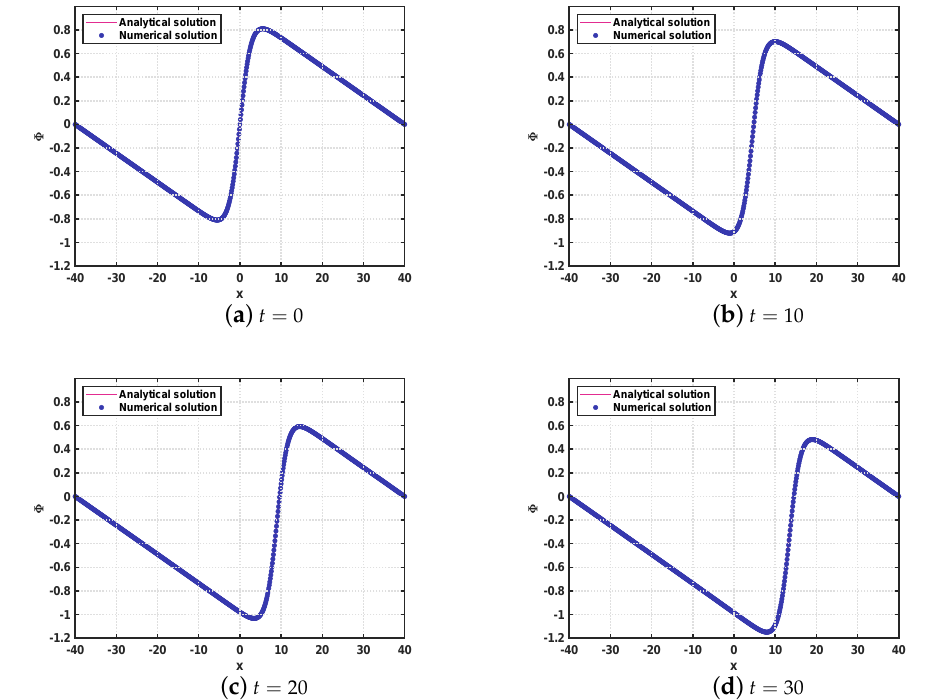
Figure 3. Comparison between numerical solution Φ f ( • ) and analytical solution Φ ( − ) with = 1 τ = τ C and h = 1 at different points in time for Case 1 of Example 2. 8 4 100